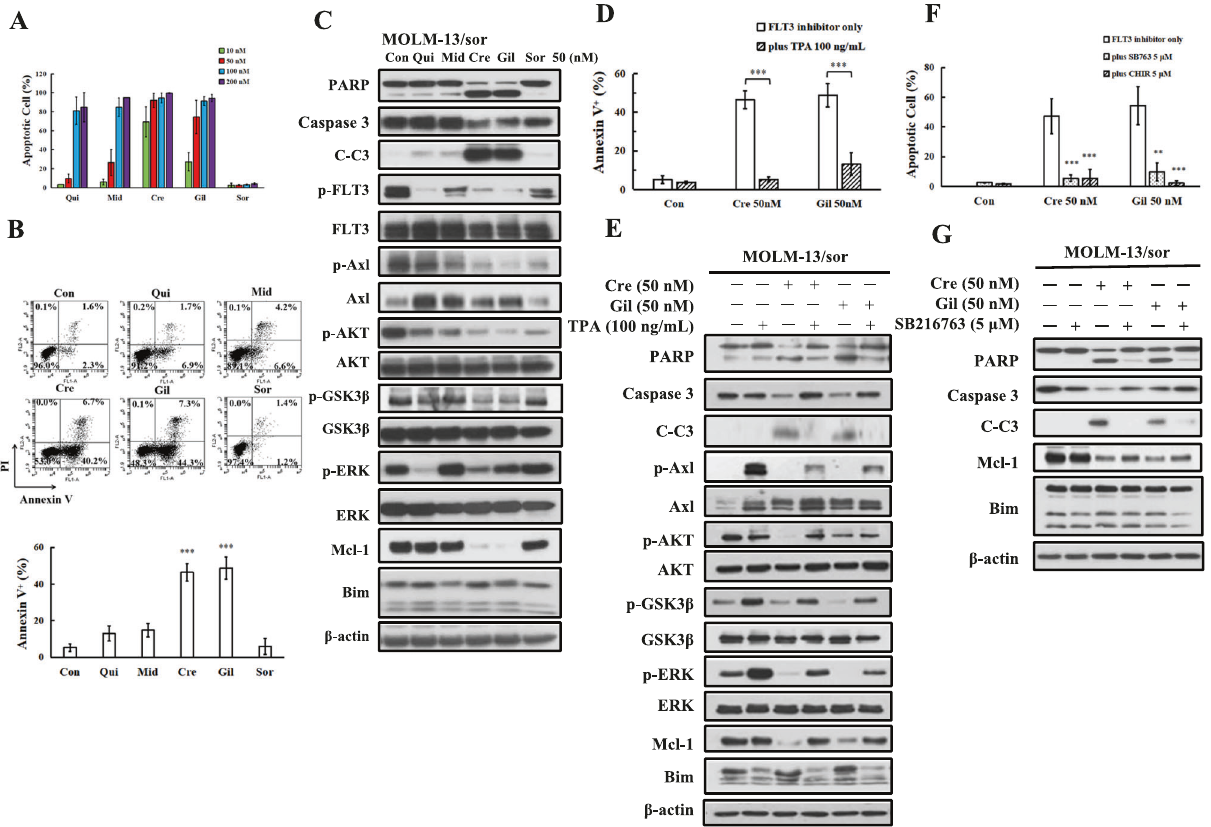
Fig. 4 Apoptosis induction and protein regulation of FLT3-ITD inhibitors in MOLM-13/sor cells. A Apoptosis detected by AO-EB staining in MOLM-13/sor cells treated with each inhibitor for 24 h. B Apoptosis detected by Annexin V/PI staining in MOLM-13/sor cells treated by 50 nM of each inhibitor. C Protein regulation in MOLM-13/sor cells treated with each inhibitor at 50 nM for 24 h. D MOLM-13/sor cells pretreated with 100 ng/mL TPA and then with crenolanib and gilteritinib at 50 nM for 24 h. Apoptosis was detected by Annexin V/PI staining. E Apoptosis- related proteins analyzed by Western blot analysis. F MOLM-13/sor cells were pretreated with 5 μ M GSK3 β inhibitor CHIR-99021 or SB216763 for 4 h and then cotreated with crenolanib and gilteritinib for 24 h. Apoptotic cells were detected by AO-EB staining. G Protein regulation in MOLM-13/sor cells treated with SB216763 in combination with crenolanib and gilteritinib for 24 h. * P < 0.05, ** P < 0.01, *** P < 0.001 compared with the FLT3 inhibitor